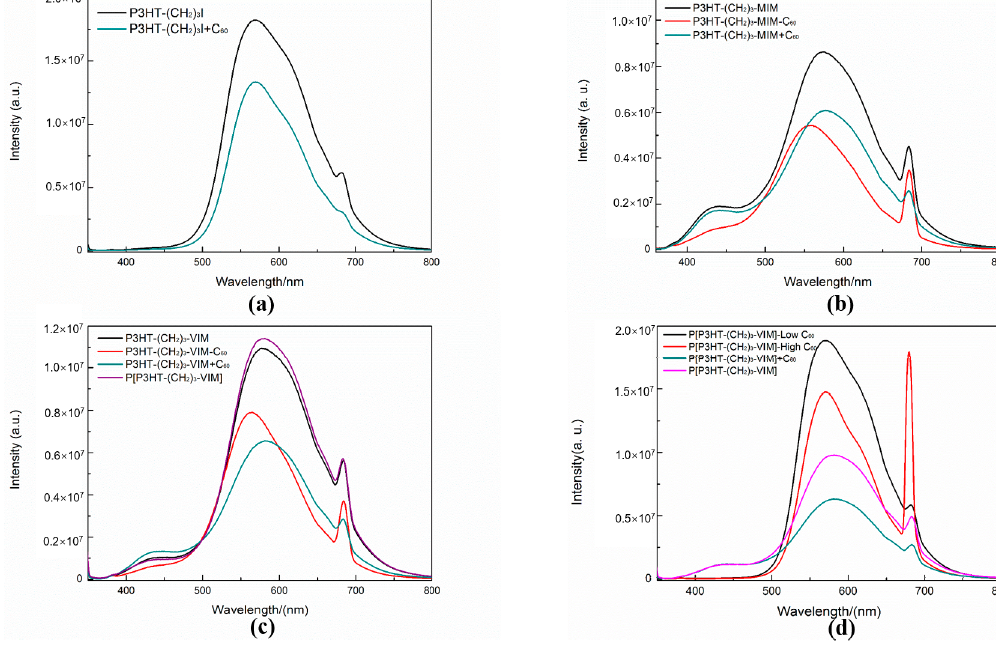
Figure 14. Fluorescence spectra (all in CHCl 3 , 9.4 × 10 − 7 M, excited at the corresponding absorption maxima 342 nm) of P3HT-(CH 2 ) 3 -I and control P3HT-(CH 2 ) 3 -I + C 60 ( a ); P3HT-(CH 2 ) 3 -MIM, P3HT-(CH 2 ) 3 -MIM-C 60 , and control P3HT-(CH 2 ) 3 -MIM + C 60 ( b ); P3HT-(CH 2 ) 3 -VIM, P3HT-(CH 2 ) 3 -VIM-C 60 , P[P3HT-(CH 2 ) 3 -VIM], and control P3HT-(CH 2 ) 3 -VIM + C 60 ( c ); P[P3HT-(CH 2 ) 3 -VIM], P[P3HT-(CH 2 ) 3 -VIM-C 60 -low], P[P3HT-(CH 2 ) 3 -VIM-C 60 -high], and control P[P3HT-(CH 2 ) 3 -VIM] + C 60 ( d ).